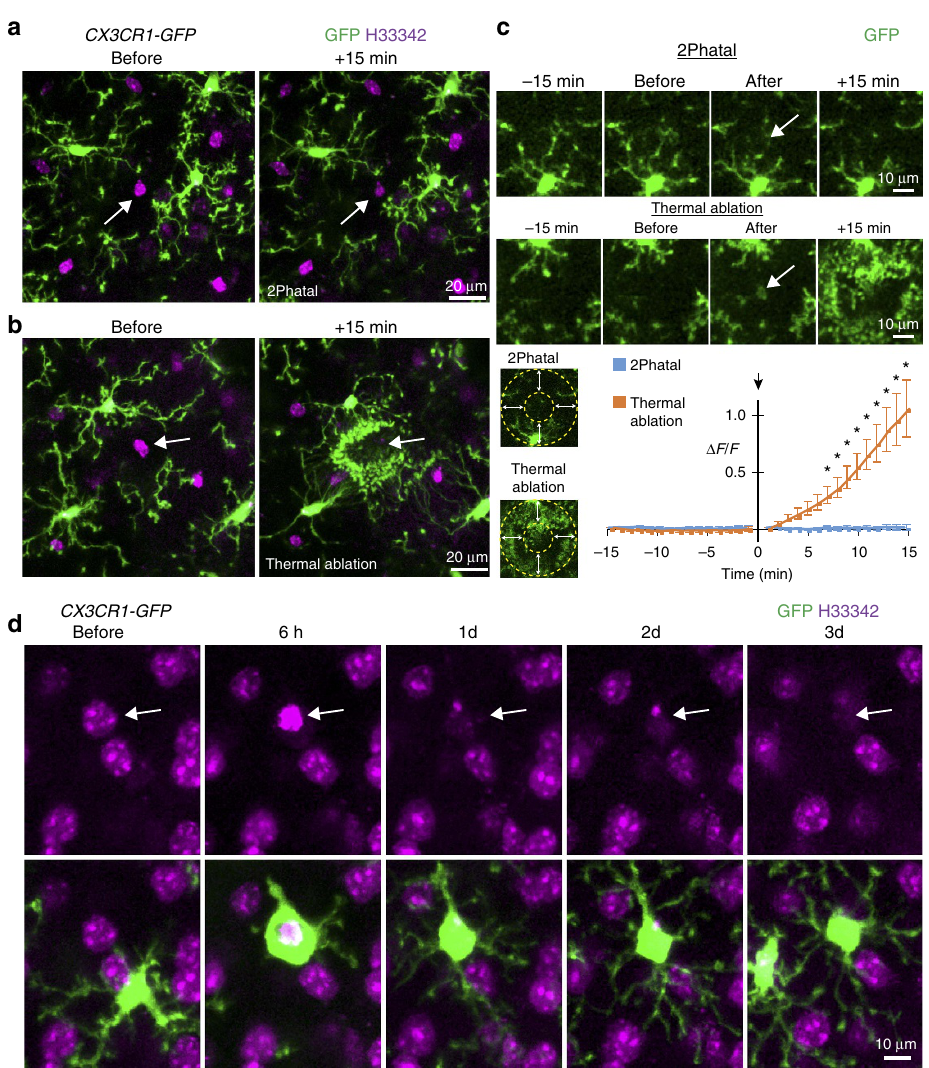
Figure 2 | Microglial engulfment and phagocytosis of targeted cells. ( a ) In vivo images showing CX3CR1-GFP -labelled microglia (green) adjacent to a cell before and after photobleaching (arrows), showing no change in microglia motility. ( b ) In vivo images showing microglia adjacent to a cell (arrows) before and after two-photon thermal ablation, showing rapid directed microglia process extension towards the mild thermal injury. ( c ) Time-lapse images and method for quantification of microglia response to 2Phatal and thermal ablation (arrows indicated targeted cell region). Unlike thermal ablation, there was no difference in microglia motility detected around cells subjected to 2Phatal; Thermal ablation n ¼ 7 cells from 4 mice, 2Phatal n ¼ 9 cells from 4 mice, traces indicate mean ± s.e.m. *Significance determined by a 99% confidence interval compared with baseline. ( d ) Extended time-lapse imaging revealed directed single-cell microglia phagocytosis of the apoptotic nuclei (arrow), providing the first system to study molecular and cellular mechanisms of single-cell apoptotic phagocytosis in vivo ( n ¼ 12 cells from 3